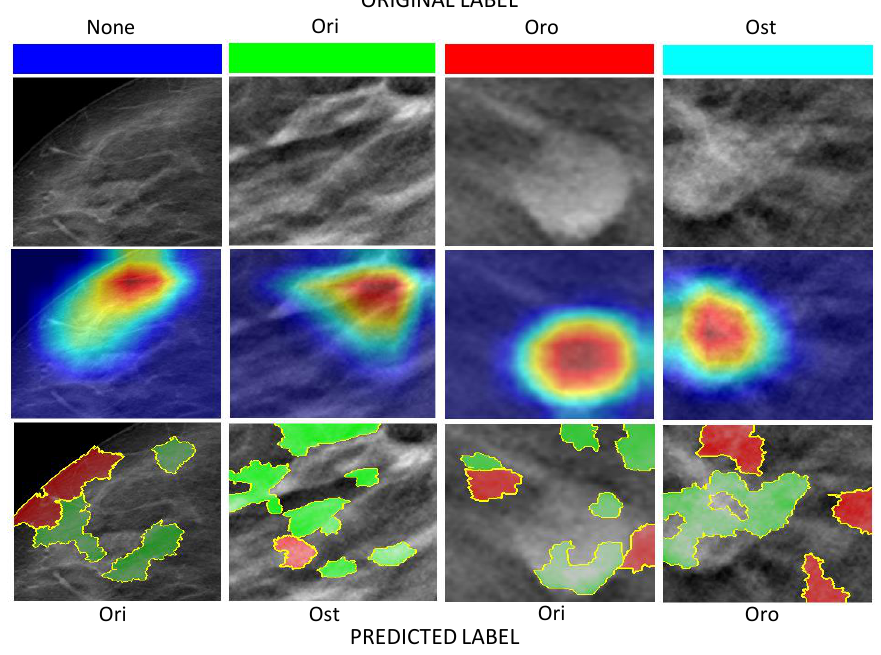
Figure 13. The examples of the misclassified samples due to the relevancy of one type of shape to other type of shape for all four classes. The labels provided above the samples represent ground truth, whereas the labels provided under the saliency maps are the predictions made by CNNs.